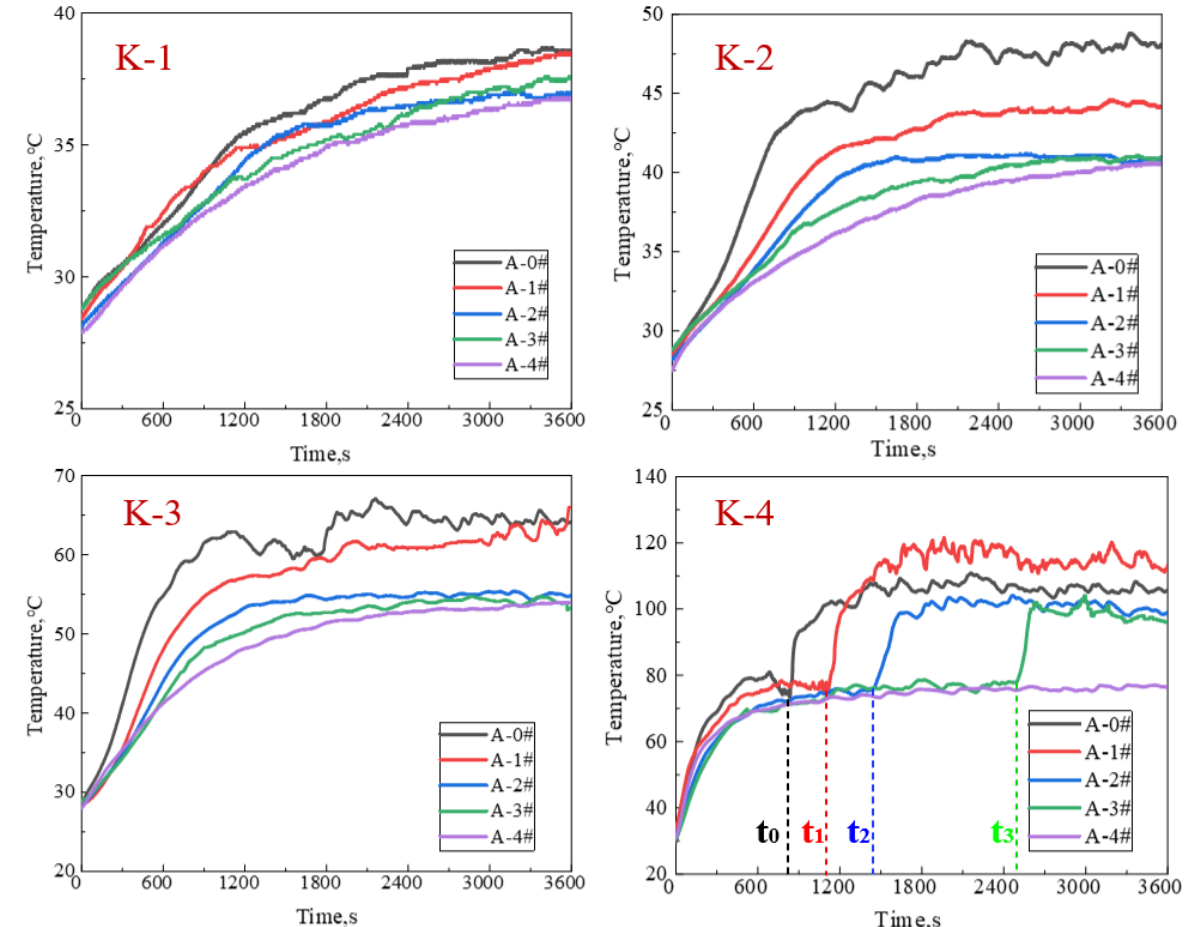
Figure 5. Temperature distribution inside foam layer at different positions under 200 ◦ C: the distance of K-1, K-2, K-3, and K-4 from the heat source are 12, 9, 6, and 3 cm, respectively.